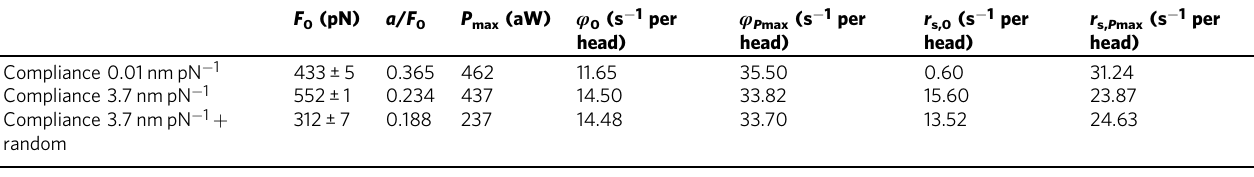
Upper row: in vivo series compliance; middle row: trap compliance; lower row: trap compliance with random orientation of motors F 0 force per half-thick fi lament, a / F 0 relative value of the parameter a of Hill ’ s hyperbolic equation 21 , P max maximum power, φ fl ux through step 1 of the cycle in Fig. 4a, corresponding to the ATP hydrolysis rate either in isometric condition ( φ 0 ) or at P max ( φ P max ), r s slipping rate within the same ATPase cycle (step “ slip ” in Fig. 4a) in isometric condition ( r s,0 ) and at P max ( r s, P max